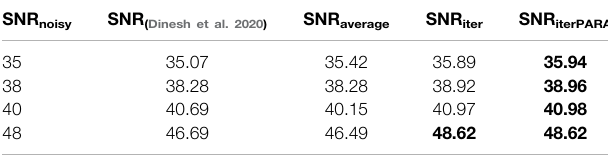
Highest values for each SNR are highlighted in